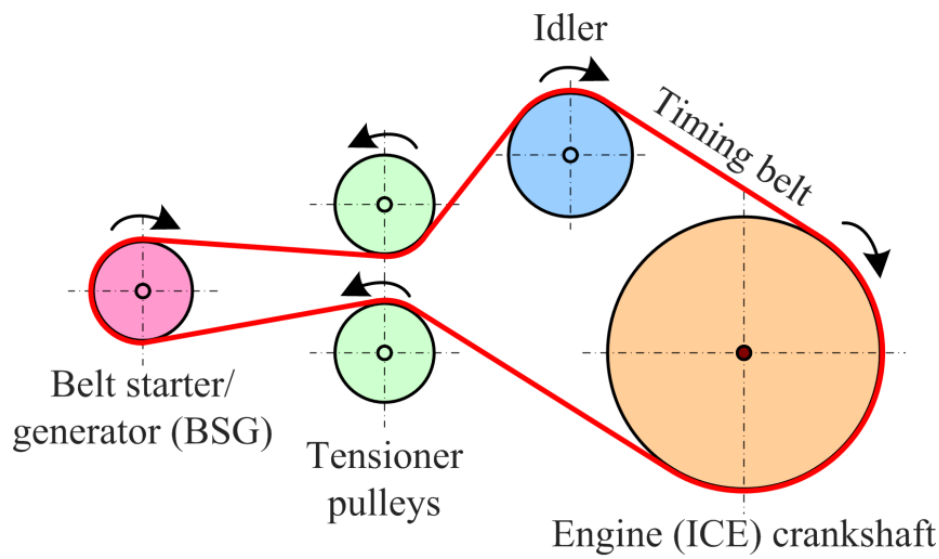
Figure 4. Principal schematic of timing belt operation.